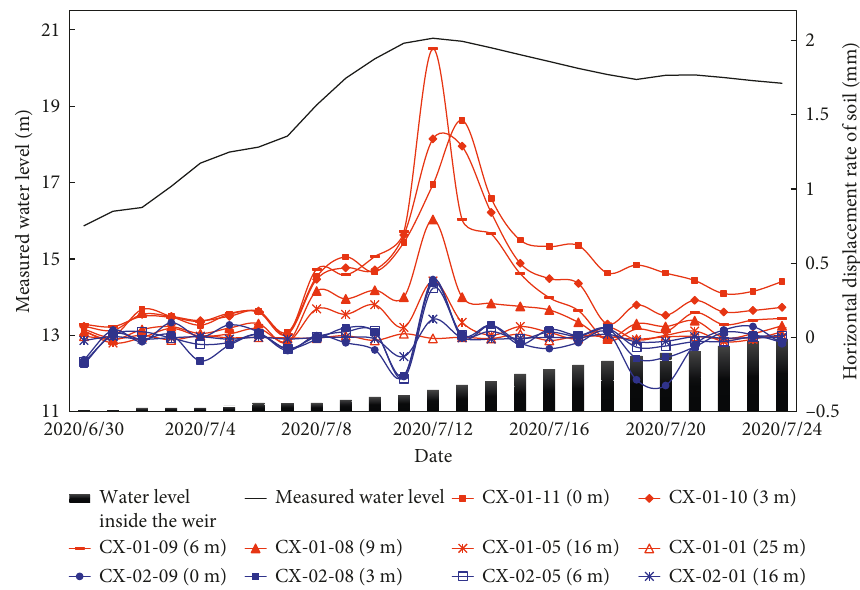
Figure 6: The displacement changing rates of CX-01 and CX-02 during the super-historical flooding period.